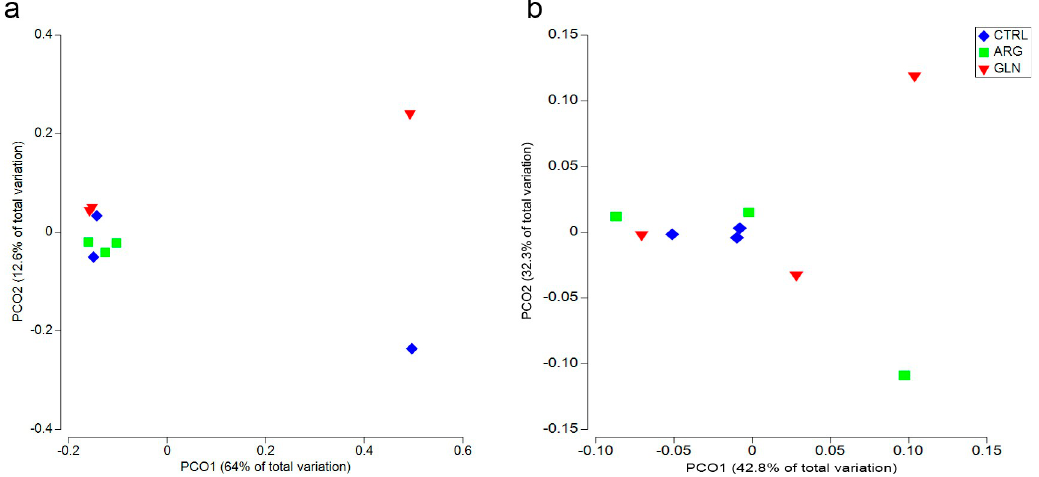
Fig 7. Principal coordinate analysis (PCoA) of unweighted and weighted UniFrac. Principal coordinate analysis (PCoA) of Unweighted (a) and Weighted (b) UniFrac for zebrafish larvae (22dpf) from control (CTRL), arginine (ARG) and glutamine (GLN)